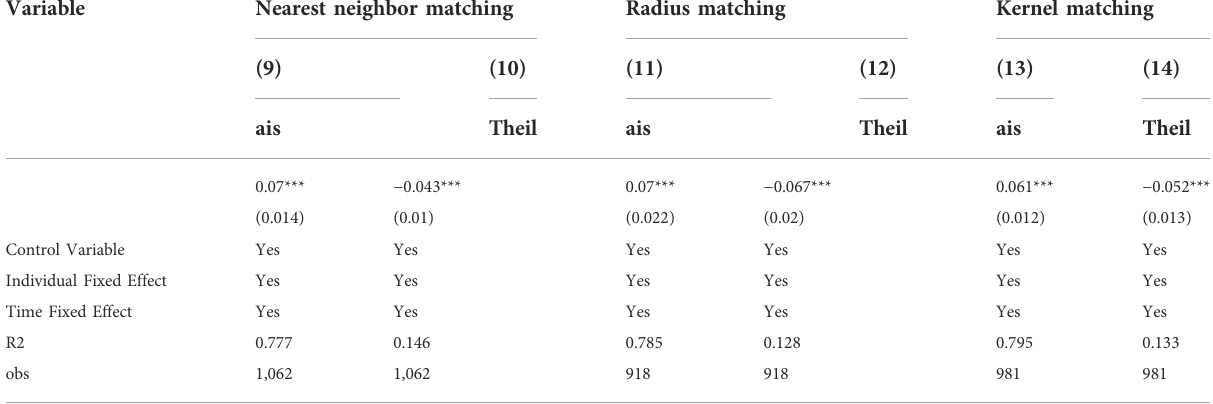
TABLE 6 Robustness test